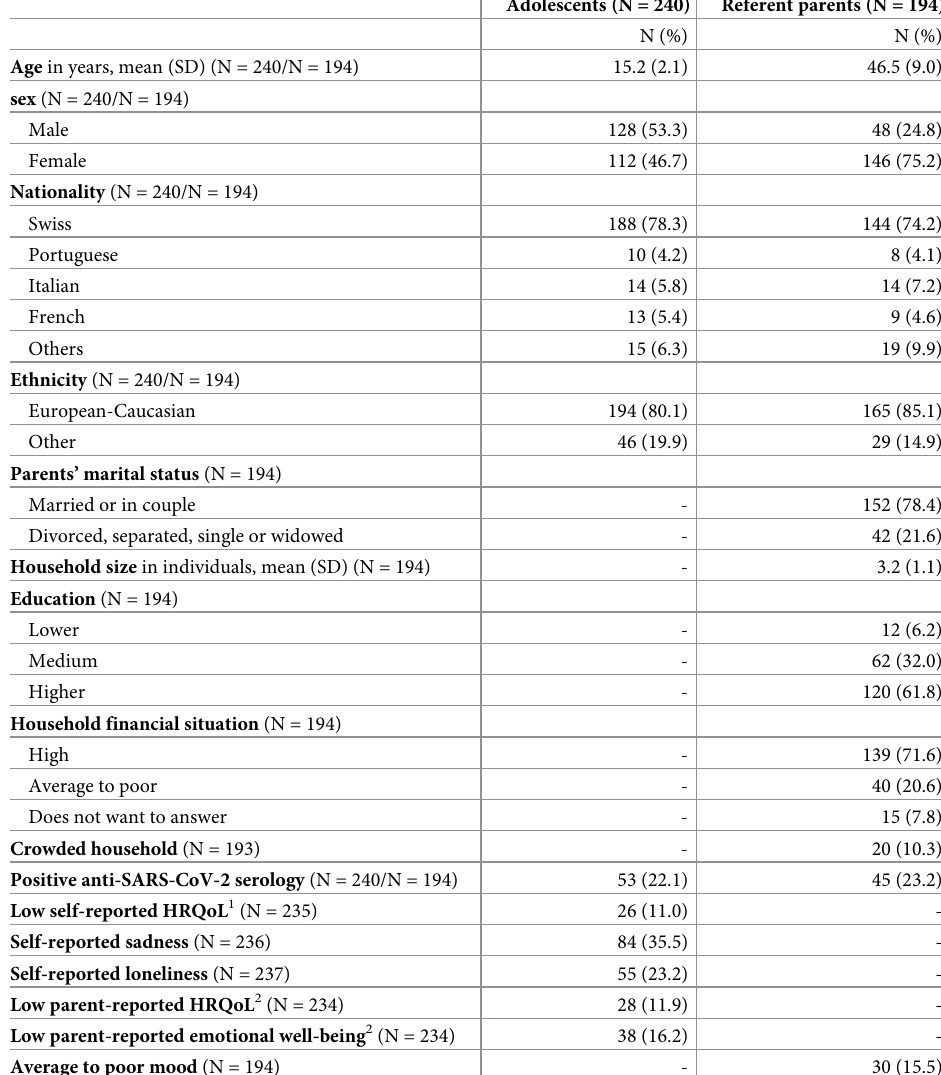
Table 1. Characteristics of the study